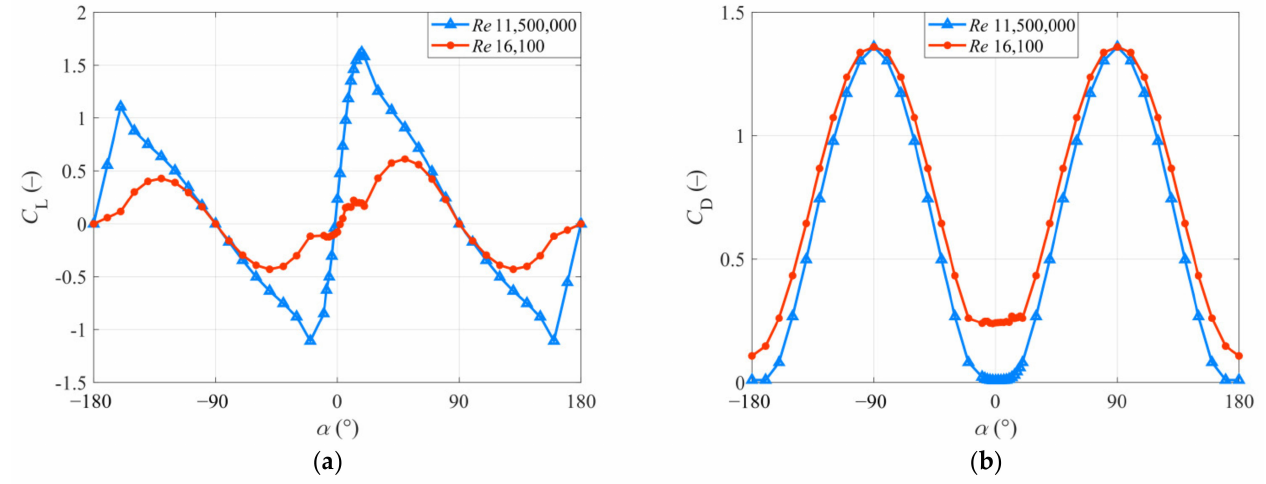
Figure 1. The aerodynamic performance of DU40 airfoil at the reference and model Reynolds numbers. ( a ) The lift coefficient. ( b ) The drag